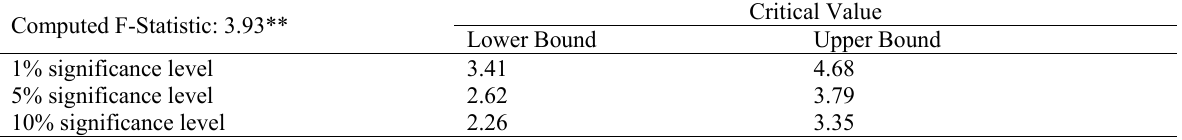
Results of Bounds Test Approach to Cointegration